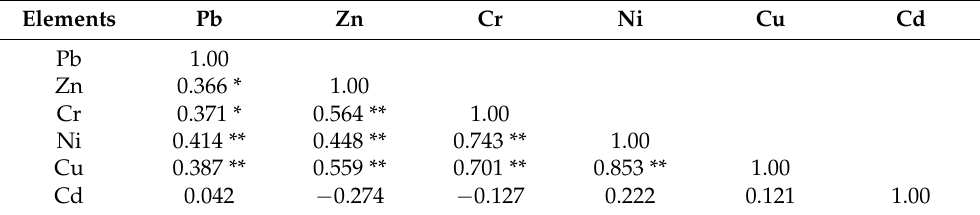
Table 3. Pearson correlation analysis of trace elements in soil samples. Elements